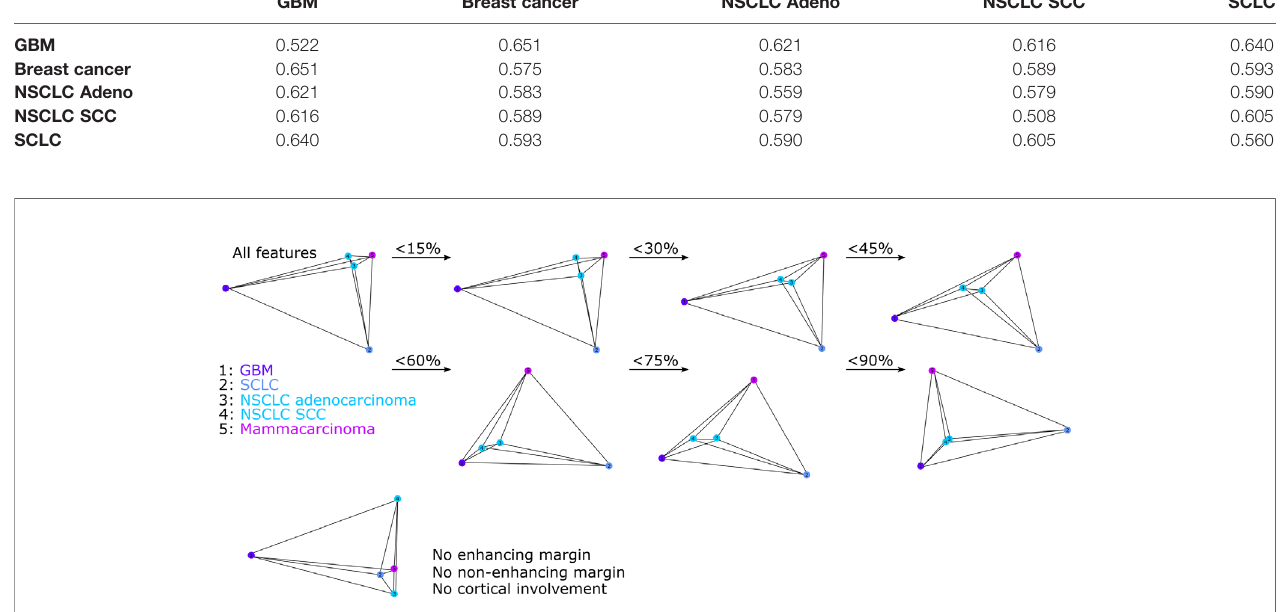
FIGURE 7 | Spectral embedding of the distance matrix for all tumor types and all VASARI features (outer left side); all features but tumor margins and cortical involvement (bottom left), and for different feature exclusion thresholds (<15 to <90%, based on